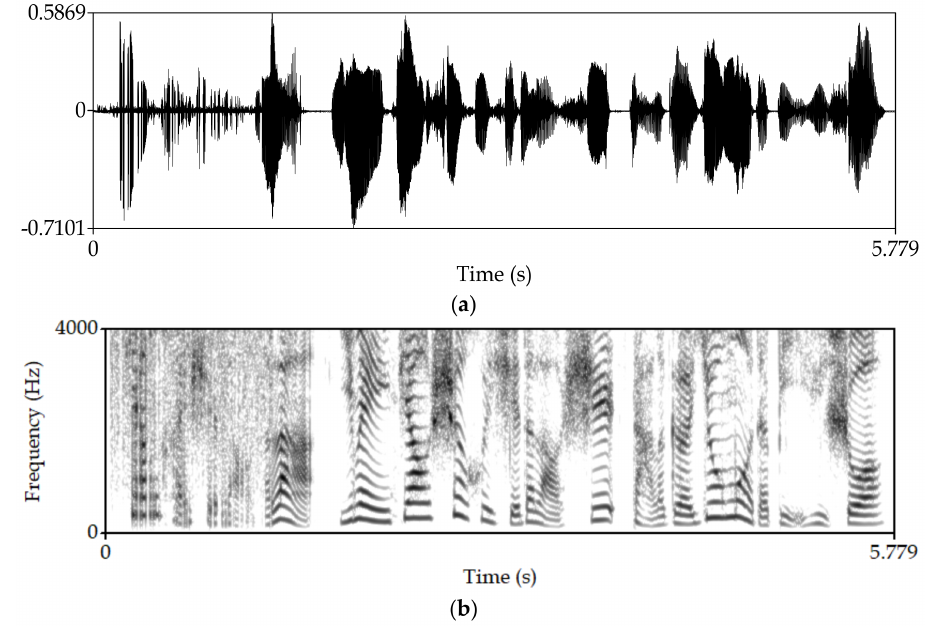
Figure 7. Recovered speech signal, the tampering percentage is 19.5% ( a ) Waveform ( b ) Spectrogram. Manipulate the speech signal with tampering percentage 47.6%. Almost half of the speech signal is tampered. Figure 8 shows the waveform and spectrogram of the damaged speech signal. Figure 9 shows the waveform and spectrogram of the recovered speech signal. From these figures, it can be seen that when the tampering percentage is as high as almost 50%, our algorithm can still recover the tampered or damaged speech, and the recovery effect is very good.